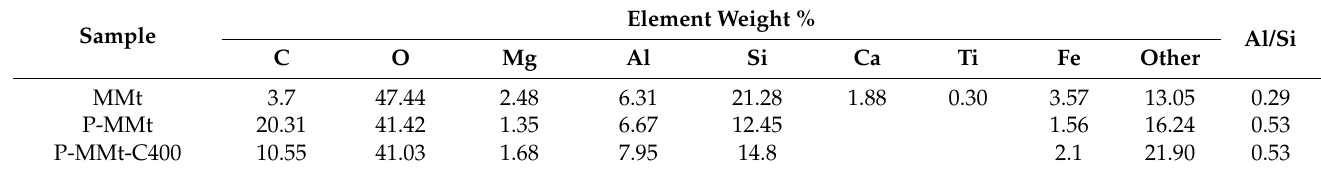
Table A1. Chemical compositions of MMt, P-MMt, and P-MMt-C400 (determined by EDX).